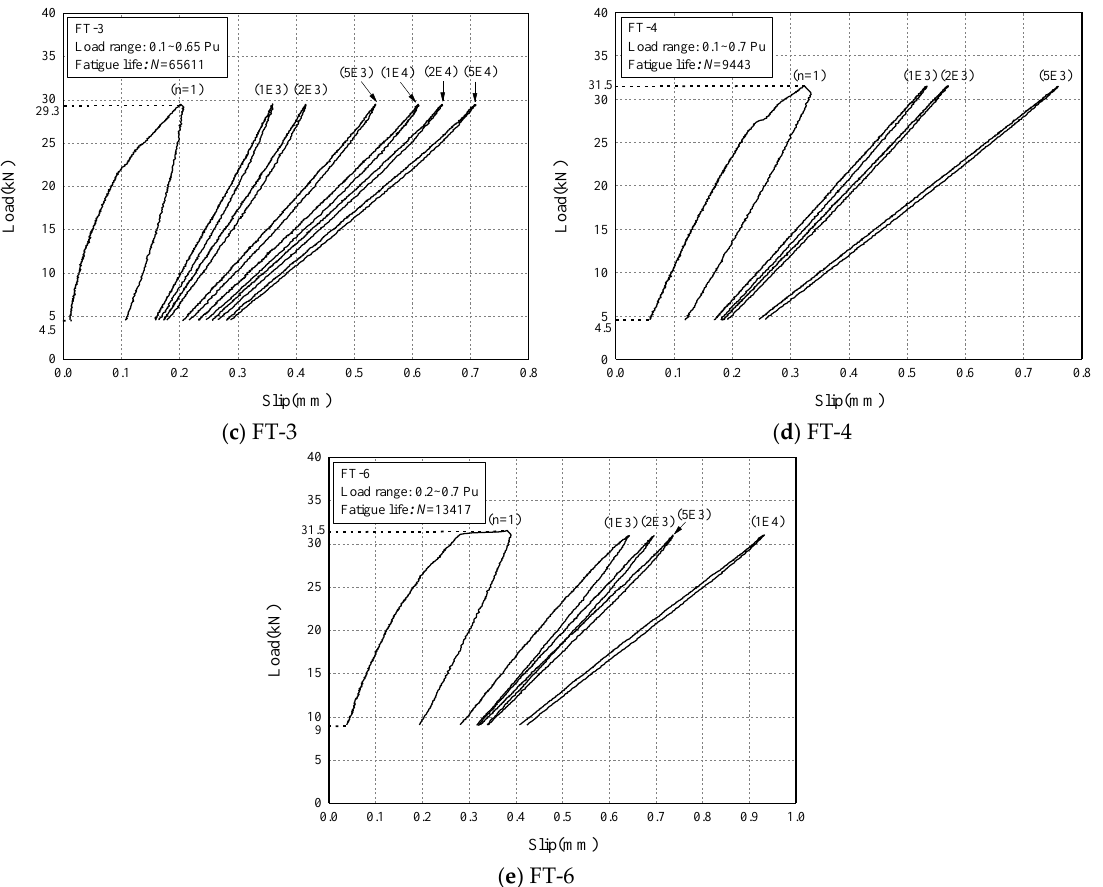
Figure 9. Load responses under fatigue loading (the number above each curve stand for corresponding cyclic number).